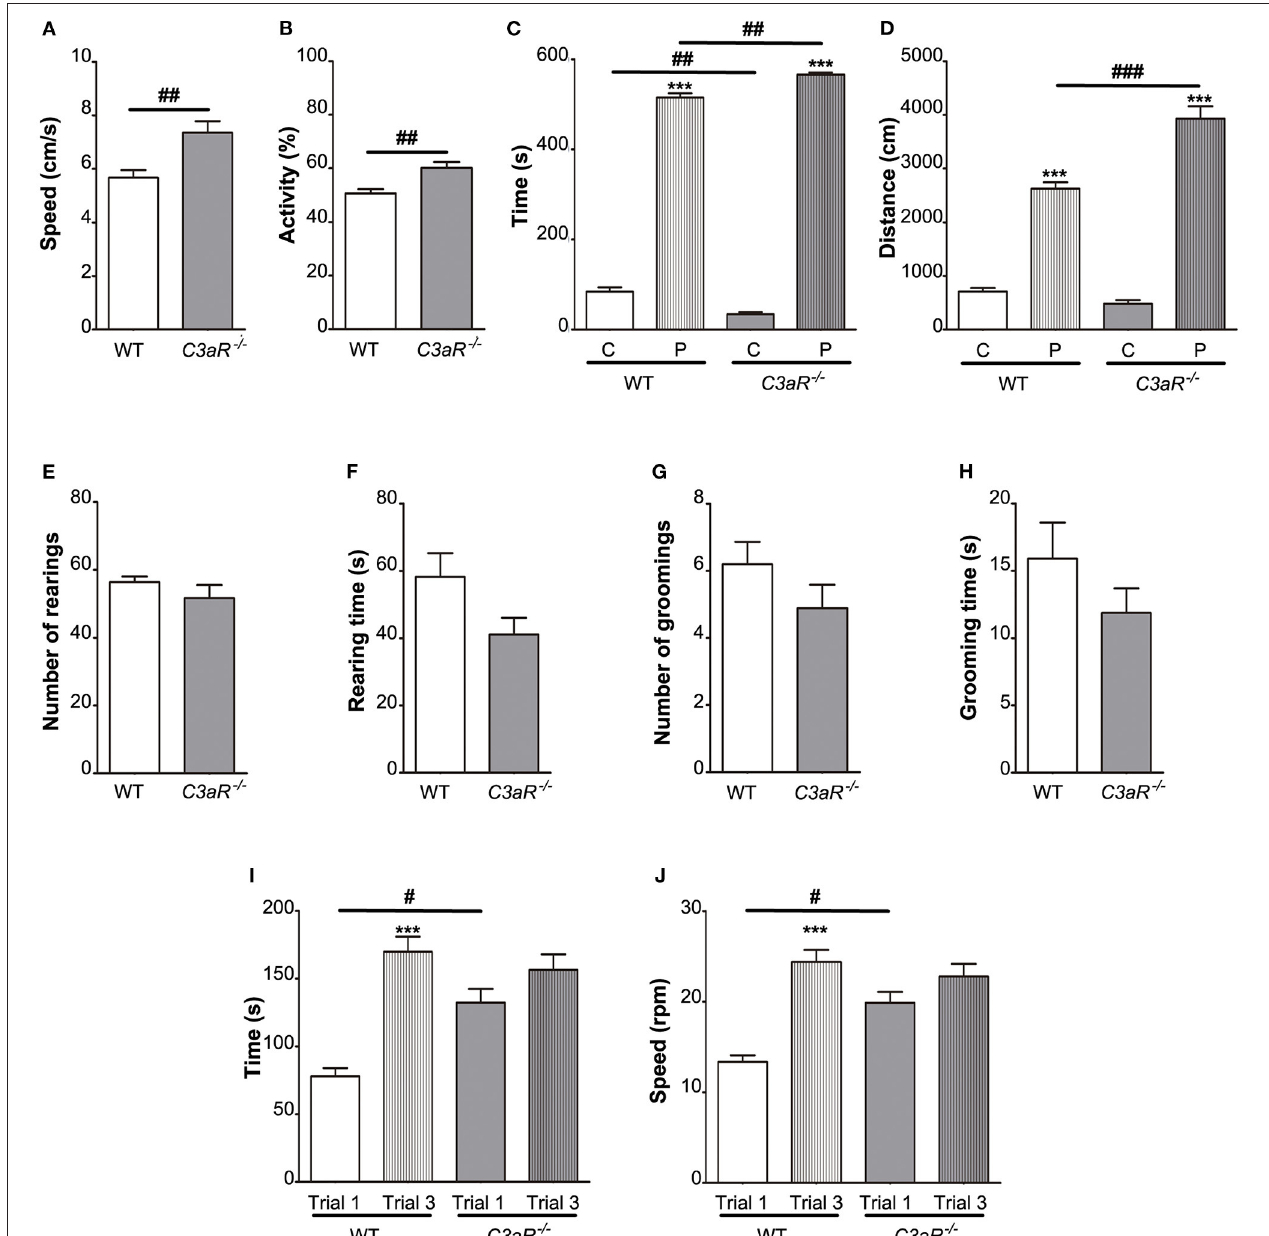
FIGURE 1 | C3aR − / − mice are hyperactive with signs of increased anxiety. Open field assessment of locomotion, anxiety-like and repetitive behavior. (A) speed, (B) relative activity presented as % of the total time, (C) time in the center, C, and periphery, P, of the arena, (D) distance covered, (E) number of rearings, (F) rearing time, (G) number of grooming episodes, (H) grooming time; n = 19 (WT) and 9 ( C3aR − / − ). Rotarod assessment of motor function, coordination, and balance (I) time, (J) max speed; n = 9 (WT) and 11 ( C3aR − / − ). Mean ± SEM. *** p < 0.001 for within group comparisons; # p < 0.05, ## p < 0.01, and ### p < 0.001 for between group comparisons. Two-tailed unpaired Student’s t -test (A,B,E–H) , and two-way ANOVA followed by a Tukey’s multiple comparisons post-hoc test (C,D,I,J) .